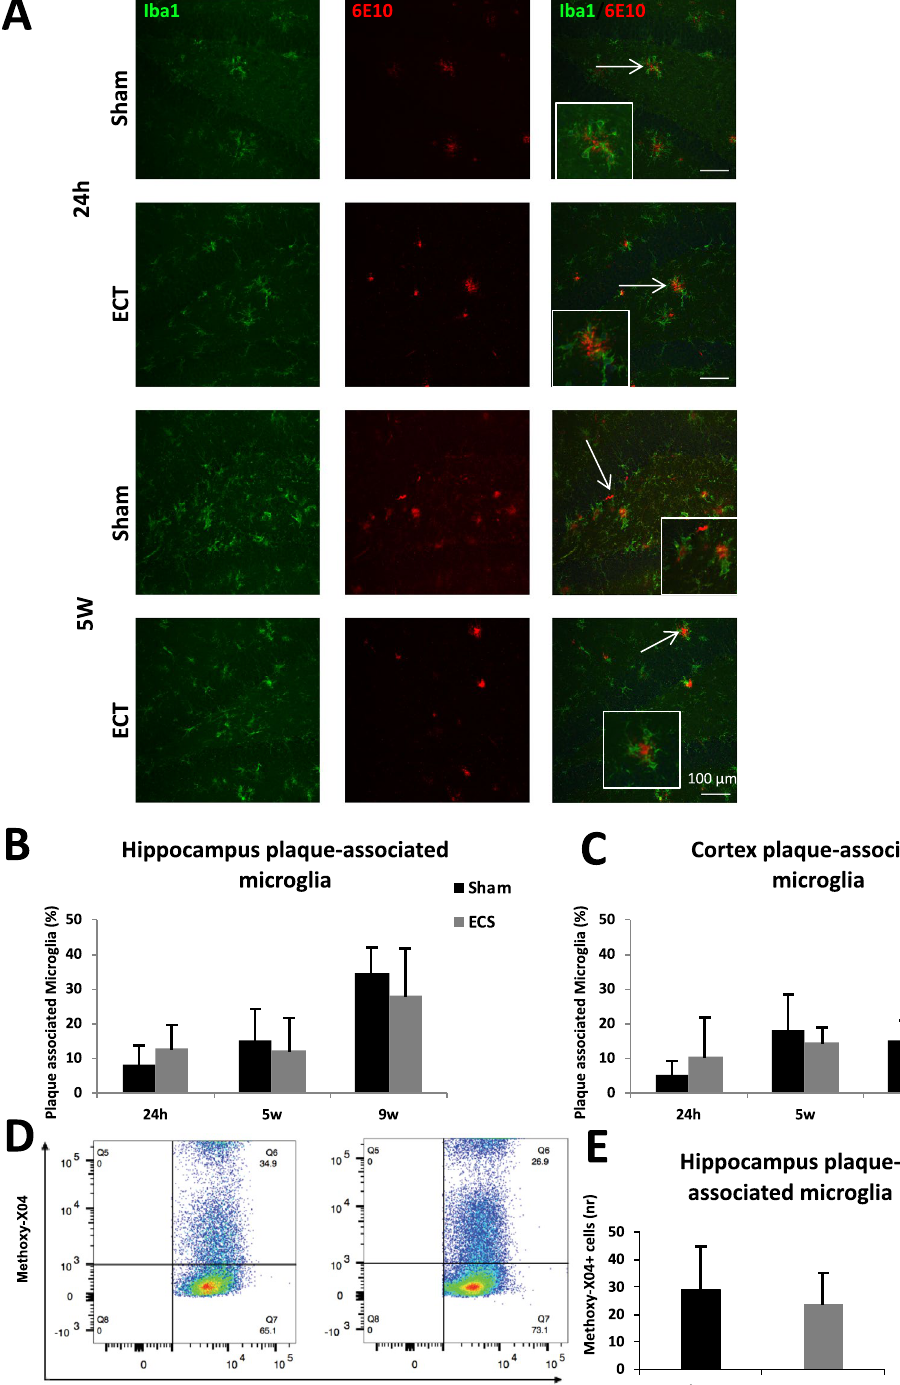
Figure 3. Effects of ECS on microglial interaction with amyloid plaques. ( A ) Representative confocal microscopy images (20 ×) visualising DAPI, Iba1 and 6E10 stainings in dentate gyrus. Scale bars represents 100 μm. Percentage of plaque associated microglia after 24 h, 5 w and 9 w in ( B ) hippocampus and ( C ) cortex. ( D ) Representative scatter plots of CD11b and Methoxy-X04 flow cytometry after 24 h and ( E ) quantification of the percentage of methoxy-X04 positive microglial cells. Bars represents mean values with error bars displaying SD. Flow cytometry was analysed with the licenced version of FlowJo 10.4.2 (https ://www.flowj o.com/solut ions/ flowj o/downl oads). Analyses were done by unpaired T-test ( p ≤ 0.05*). For the 24 h groups, n = 7 for sham and n = 8 for ECS. For the 5 weeks groups, n = 9 for sham and n = 9 for ECS. For the 9 weeks groups, n = 5 for sham and n = 6 for